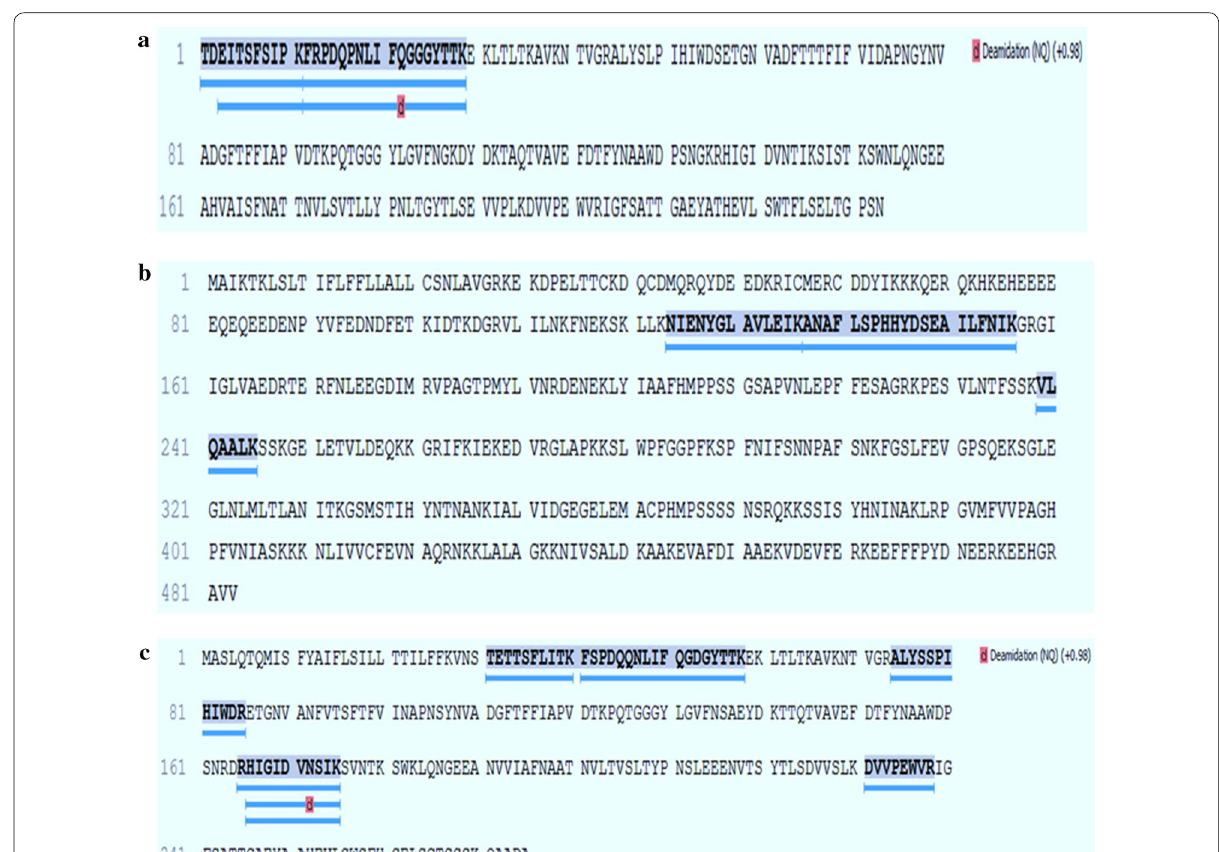
Fig. 5 a Shows amino acid sequences fava bean lectins (Favin (P02871|LEC_VICFA). However, data is often searched the variable modification deamidation NQ ( 0.98 Da) of asparagines (N) and glutamines (Q). b Shows amino acid sequences lentil lectins. c Shows amino acid sequences pea + (psl) lectins. However, data is often searched the variable modification deamidation NQ (